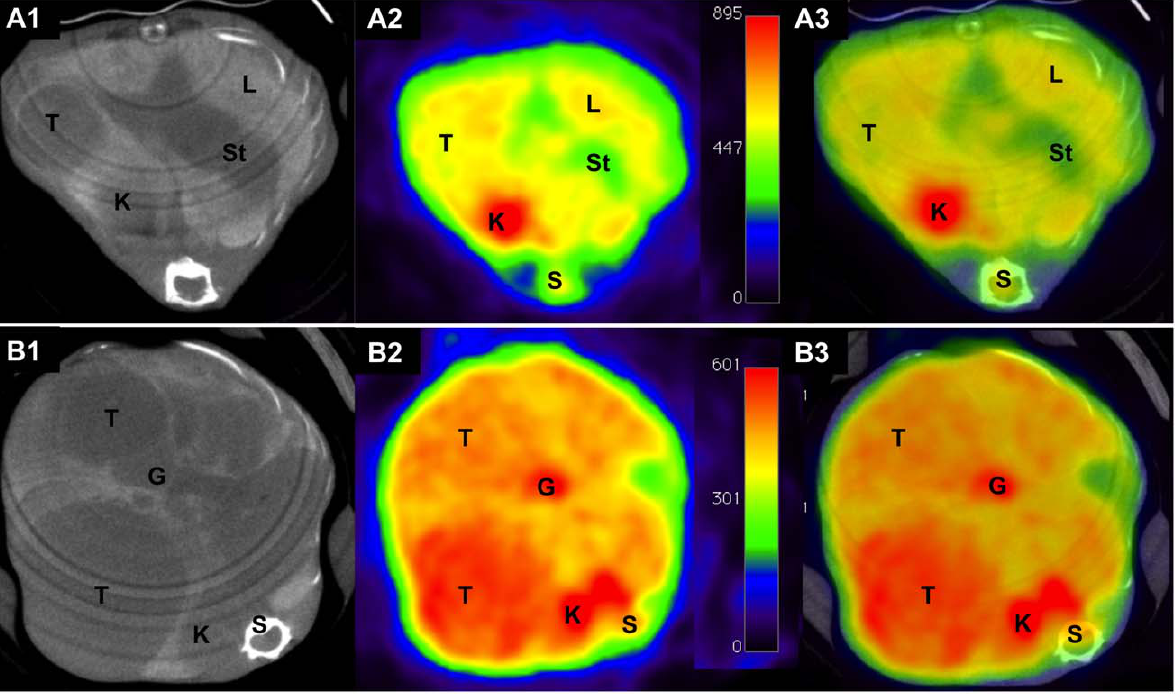
Figure 3. Contrast-enhanced CT, 18 F-FDG-PET and fused images of c-Myc transgenic mice treated with NDEA at the age of 5.5 and 7 months. (A) CT image demonstrates a single tumor lesion (A1) in a 5.5 months old mouse without increased 18 F-FDG uptake (A2). The fused CT and PET image is depicted in A3. (B) At the age of 7 months expansive tumor growth (B1) as well as an increased tracer uptake in hepatocellular carcinoma (B2) is observed. The fused CT and PET image is depicted in B3. G=gallbladder, K=kidney, L=liver, S=spine, St=stomach, T=tumor. doi:10.1371/journal.pone.0030432.g003 PLoS ONE |